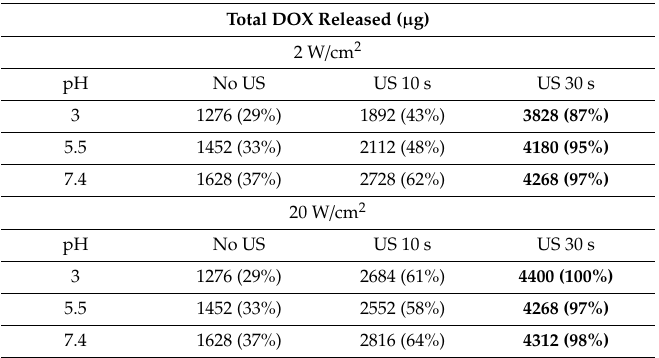
Table 1. Total amount of DOX (µg) released from 10 mg of the carrier in different media and US conditions. Data refer to the release trend illustrated in Figure 5. Bold represents the amount of DOX released which exceed 80% of the initial load.